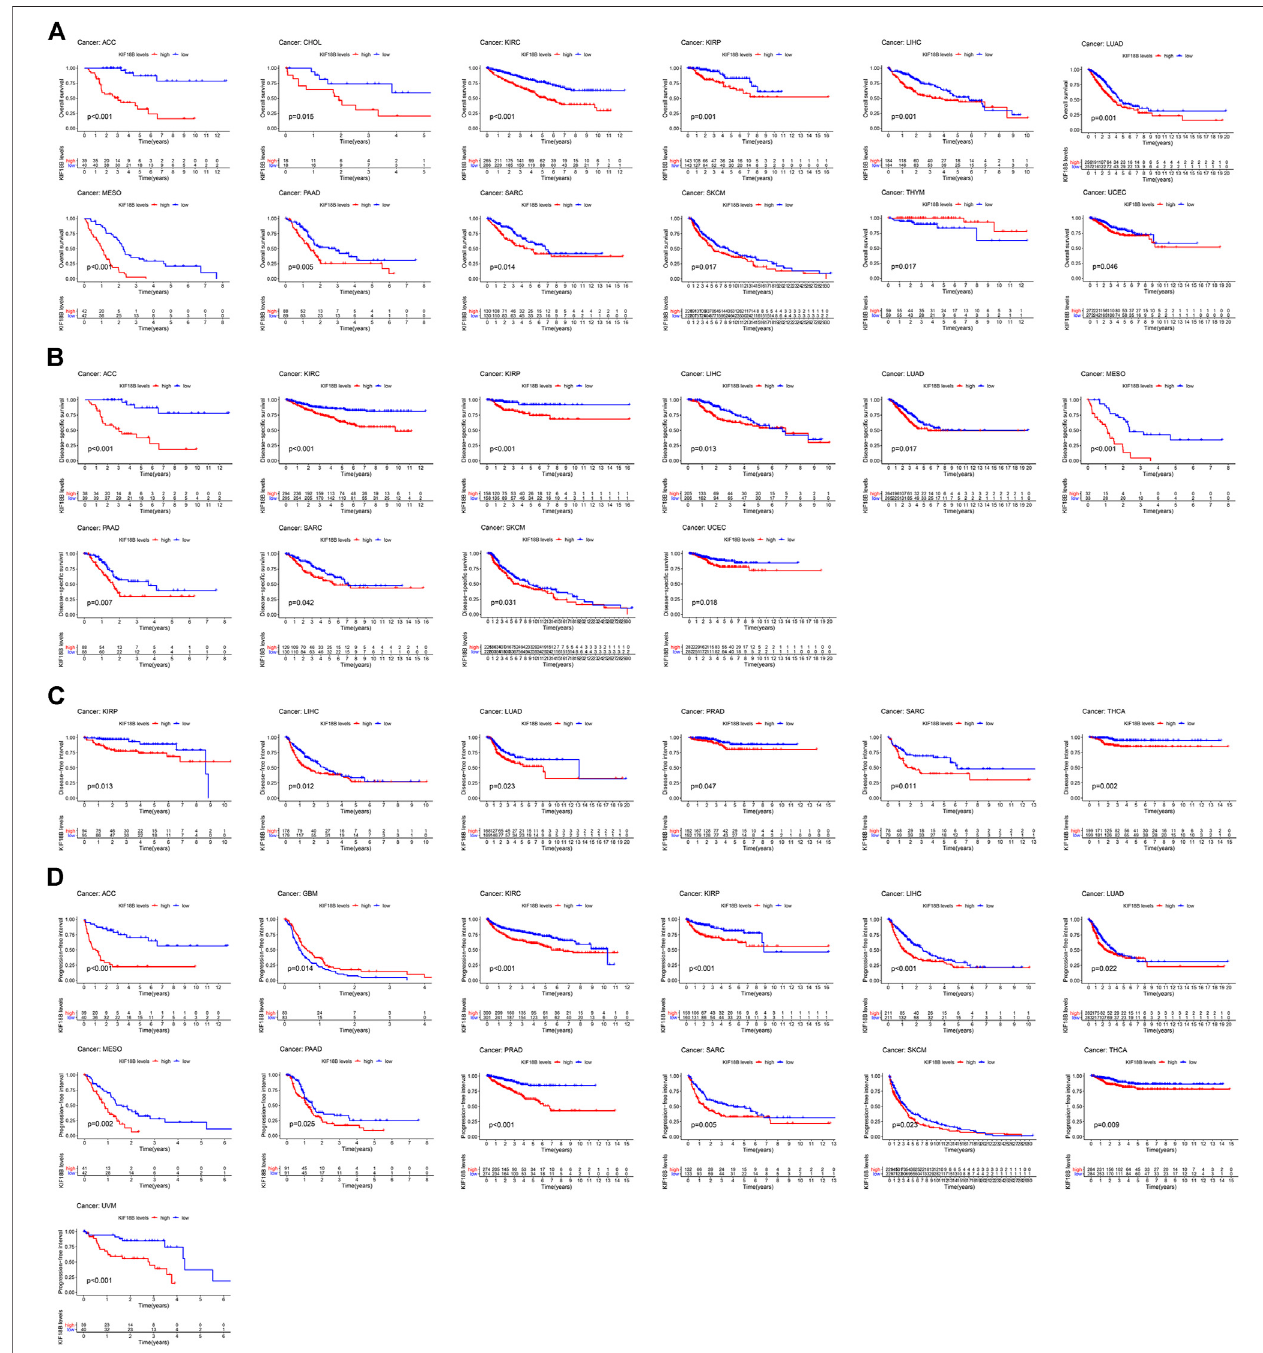
FIGURE3| Thesurvivalcurve ofKIF18B invarious cancersusing Kaplan-Meier methodsand thelog-rank test. Values of p < 0.05 wereconsidered and displayed. (A) ThesurvivalcurveofKIF18BforOSin12typesofcancers. (B) ThesurvivalcurveofKIF18BforDSSin10typesofcancers. (C) ThesurvivalcurveofKIF18BforDFSin 6 types of cancers. (D) The survival curve of KIF18B for PFI in 13 types of cancers.